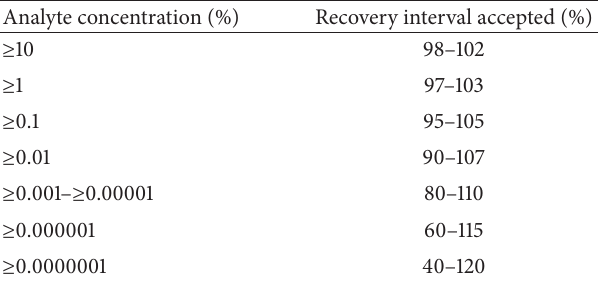
Table 7: Recovery of analyte according to the